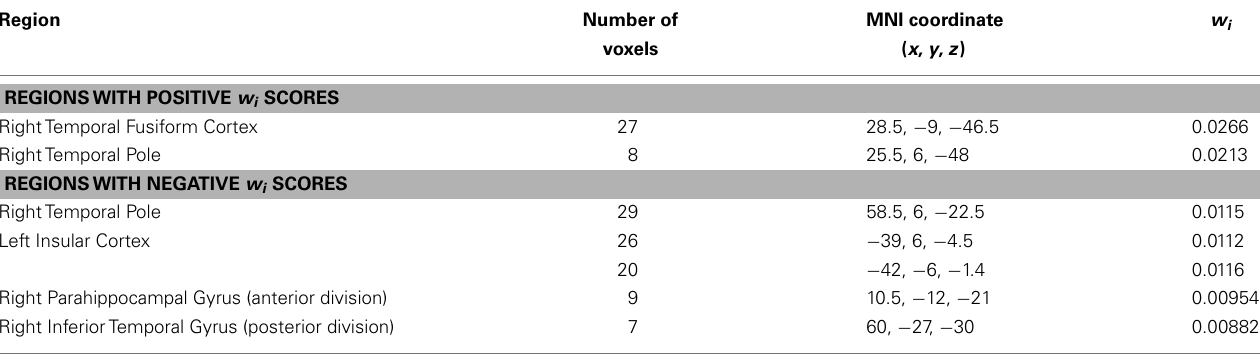
Table 2 | Neuroanatomical regions with a weight vector score in the top and in the bottom 30% of the maximum weight vector score across all regions for the cortical thickness based RVR used to accurately predict the difference between baseline and follow up total PANSS score .